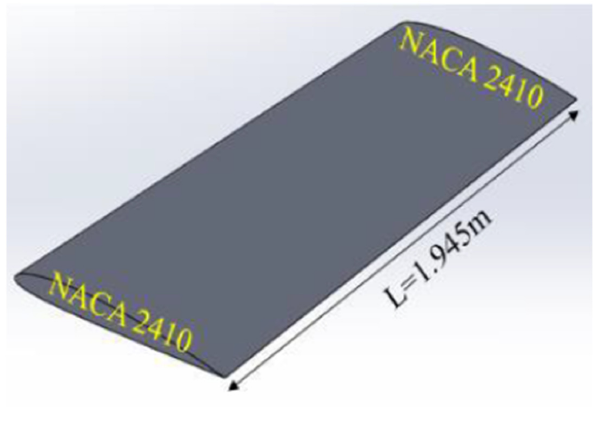
Figure 3. NACA8410-2410 wing under stress model. 3.2.1. NACA Four-Digit Airfoil Specification This NACA airfoil is characterized by four-digit NACA MPXX, which determines the camber, maximum camber position, and airfoil thickness, respectively. M is the num- ber of the maximum camber divided by 100, and P is the number of the position of the maximum camber divided by 10. The remaining two digits, denoted XX, indicate the thickness divided by 100. For instance, NACA2412, where M = 2, where camber is 0.02 or 2% of the chord, P = 4, the maximum camber is positioned at 0.4 or 40% of the chord, and XX = 12, the thickness is 0.12 or 12% of the chord [56]. The equations for camber geometry generation are tabulated in Table 1. Table 1. Camber rate and gradient of geometry for airfoil description. Front (𝟎 ≤ 𝒙 (cid:3407) 𝒑) Back (𝒑 ≤ 𝒙 ≤ 𝟏) Camber Rate